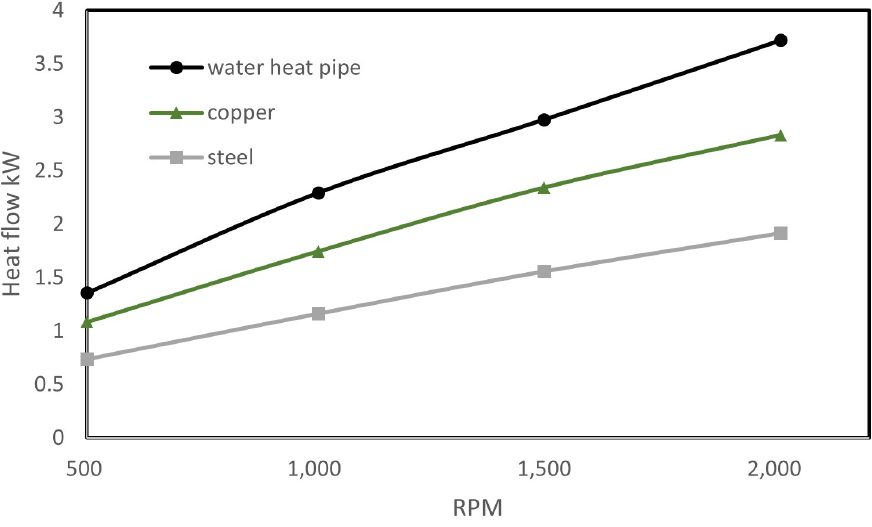
Figure 5. Heat transported by RRHP and metal rods (data from [24]).